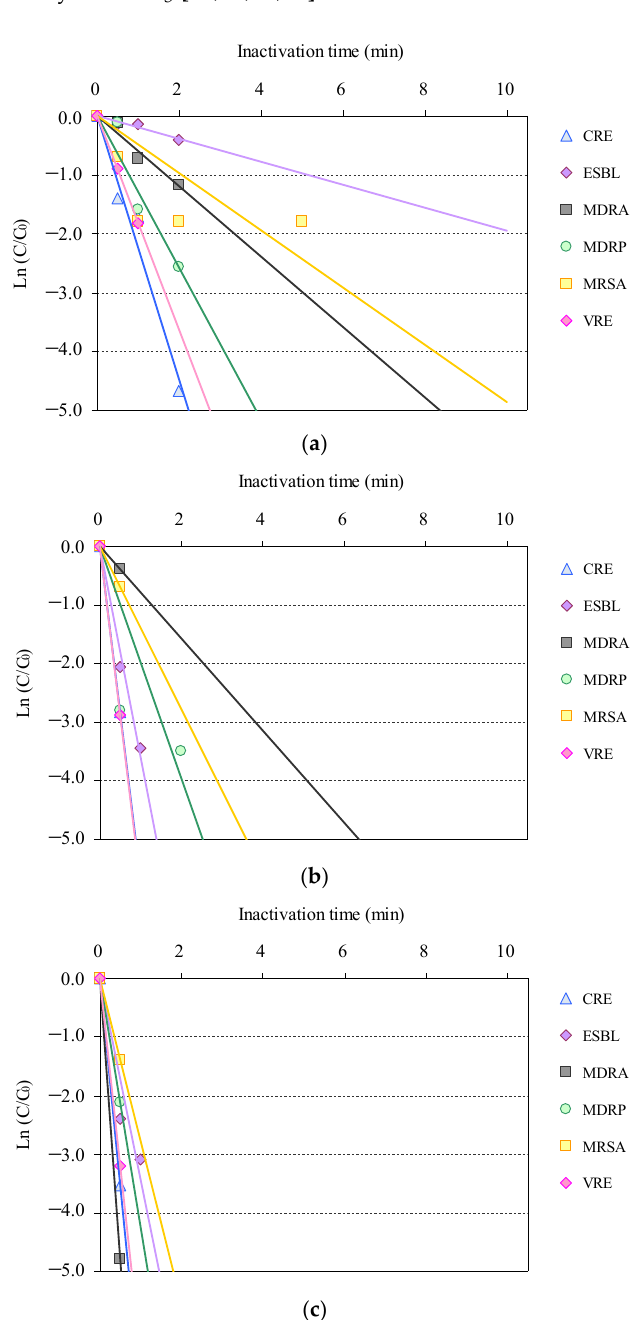
Figure 1. Relative residual antimicrobial-resistant bacteria (AMRB) under O 3 -based AOP treatment (C 0 : initial bacterial counts; C: bacterial counts after treatment): ( a ) O 3 /H 2 O 2 , ( b ) O 3 /UV, ( c ) O 3 /UV/H 2 O 2 . (CRE: carbapenem-resistant Enterobacteriaceae , ESBL-E: extended-spectrum β -lactamase-producing Enterobacteriaceae , MDRA: multidrug-resistant Acinetobacter , MDRP: multidrug- resistant Pseudomonas aeruginosa , MRSA: methicillin-resistant Staphylococcus aureus , and VRE: vancomycin-resistant Enterococcus ).